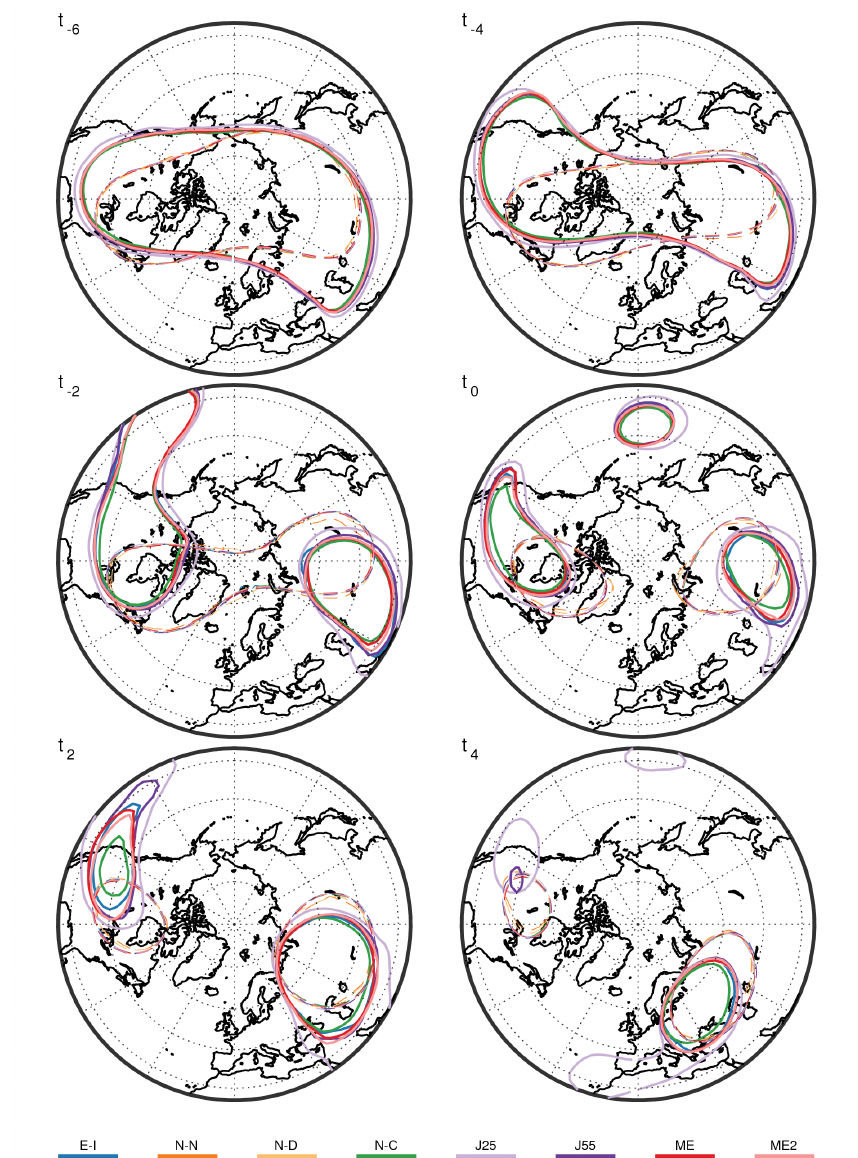
Figure 2. Vortex geometry at 10hPa (dashed) and 3hPa (solid) during the 2009 SSW for different reanalysis datasets (colors). The 30km contour is illustrated at 10hPa and the 38.5km contour is shown at 3hPa. The central date ( T 0 ) is set as 24 January